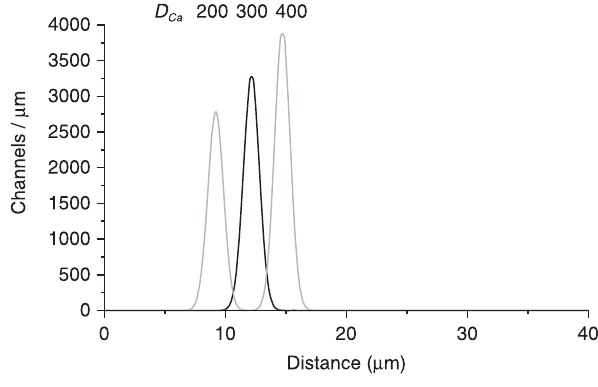
Figure 6. Sensitivity analysis of the model. For each of five parameters used in the model (unitary conductance of the channel g Cl , the Hill constant n , K 1/2 for activation of channels by Ca 2 + , the dissociation constant K B between Ca 2 + and BAPTA, and the number of Ca 2 + -binding sites per channel B S ), three values were assumed. For the first four parameters, the values were the mean experimental value and the mean plus or minus the standard error as shown in Table S2 of Text S1. For the number of binding sites, values of 1, 2, and 3 were assumed. For each of the resulting 3 5 =243 permutations of values, the inverse solver generated a channel density function. The average of the 243 functions is shown as a black curve. This average function peaked at 12.2 m m and represented a total (integrated area) of 5329 channels. For this analysis a sixth parameter, the diffusion coefficient of Ca 2 + in the cilium ( D Ca ), was assumed to be 300 m m 2 s 2 1 . Repeating the analysis with D Ca =200 m m 2 s 2 1 gave an average density function centered at 9.2 m m with 4490 channels; assuming D Ca =400 m m 2 s 2 1 gave a function centered at 14.7 m m with 6230 channels (curves shown in gray). Varying D B , the diffusion coefficient of BAPTA, between 65 and 125 m m 2 s 2 1 had no significant effect (not shown). The recording used for sensitivity analysis was the same as that shown in Fig.